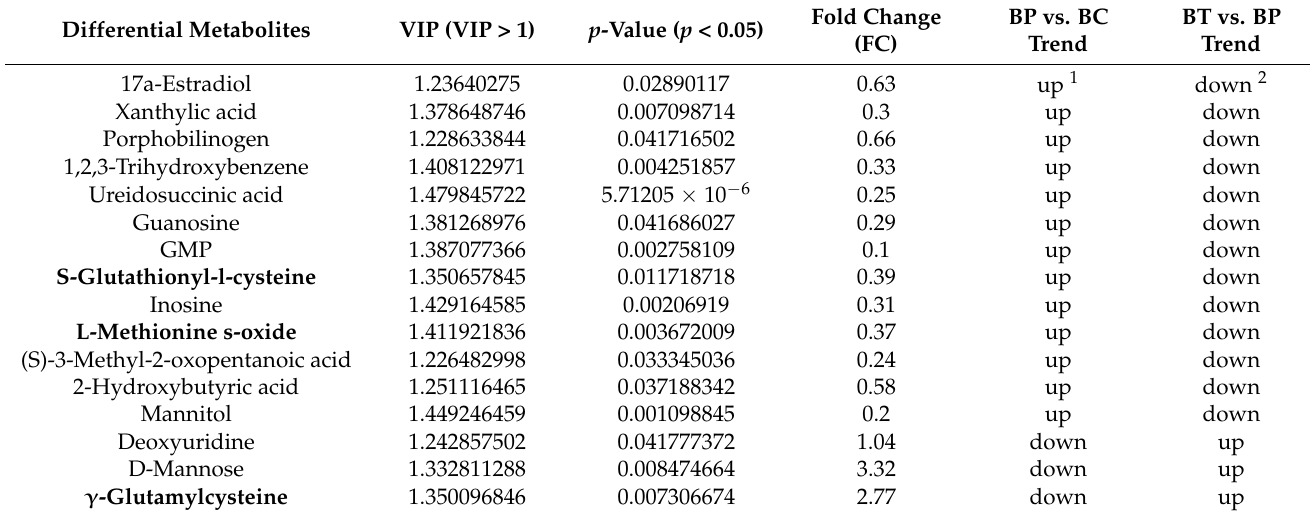
Table 2. The information of 16 significantly different metabolites.